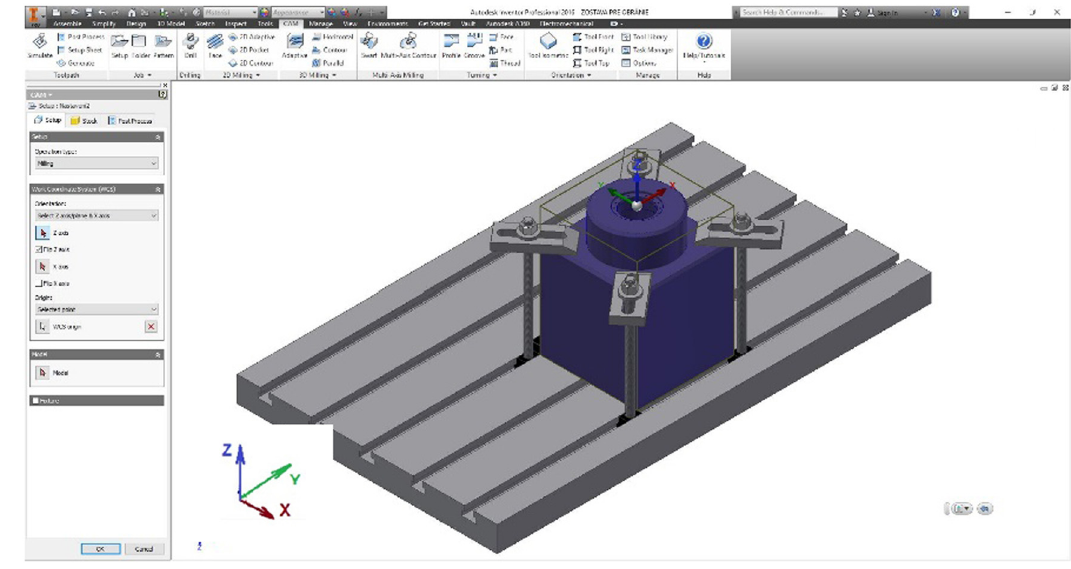
Figure 4: Setting of zero point of the robot